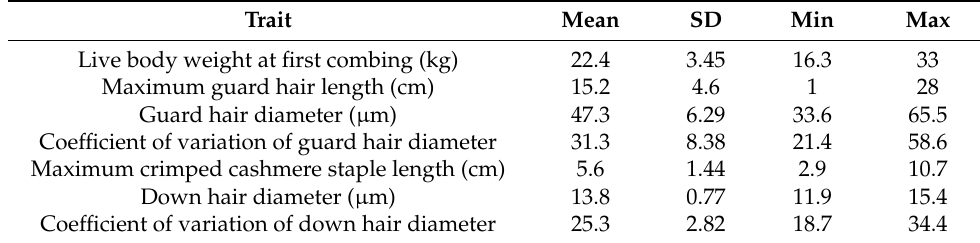
Table 1. Descriptive statistics for fiber traits in ALBWCG.